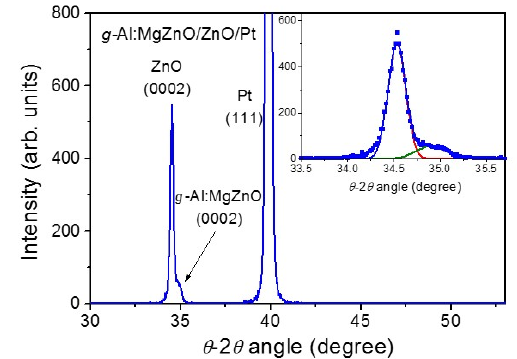
Figure 3. The XRD result for g -Al:MgZnO/ZnO heterostructure film. The inset is a Gaussian fitting of the XRD peaks for ZnO (0002) and g -Al:MgZnO